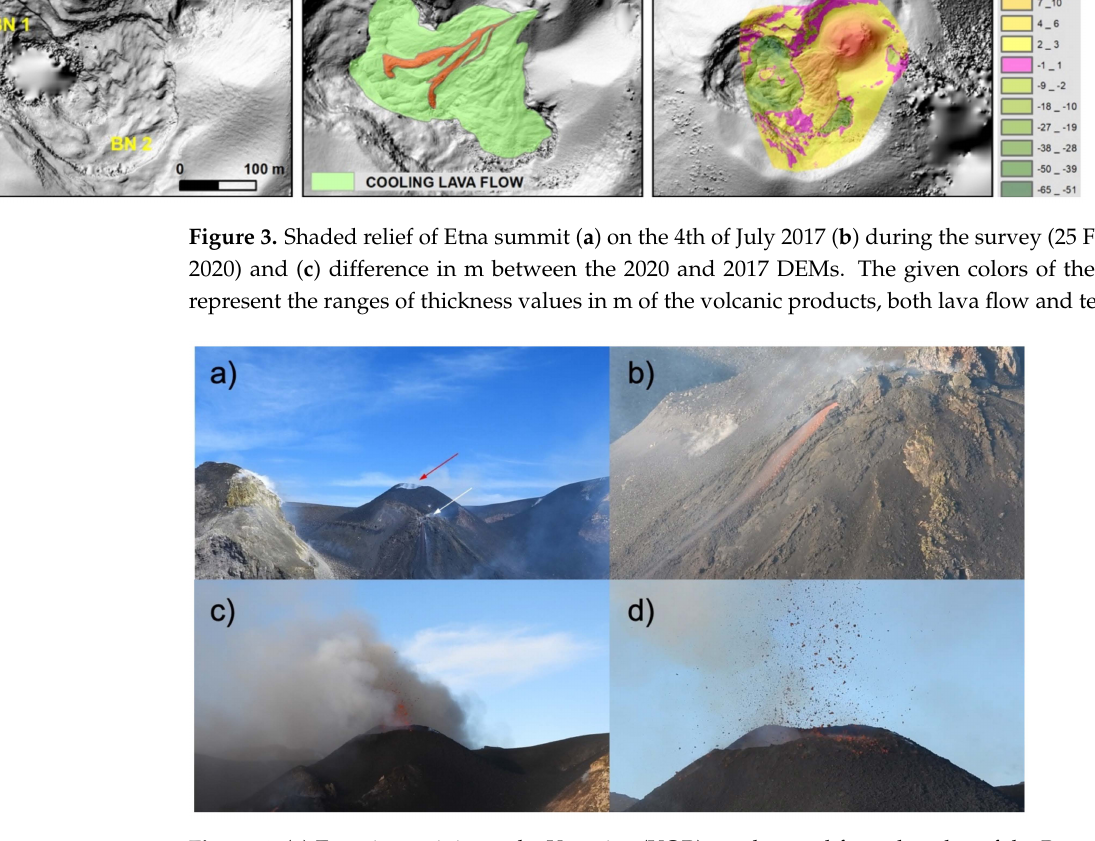
Figure 4. ( a ) Eruptive activity at the Voragine (VOR), as observed from the edge of the Bocca Nuova Crater (BN) on 25 February 2020. Red arrow points to the explosive vent, white arrow to the lava vent. ( b ) Close-up of the active lava flow. ( c ) Strombolian explosion and ( d ) close-up of explosion; bombs are partly falling back in the crater and on the crater rim and partly on the slopes of the